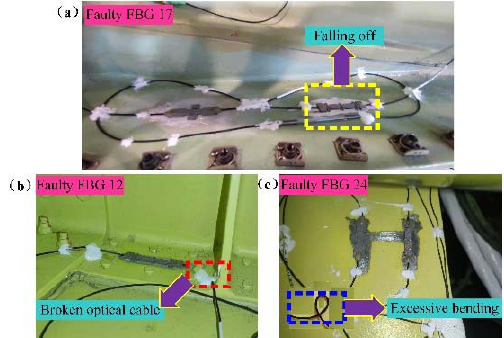
Figure 12. Diagram of faulty FBG sensors on airplane. ( a ) Falling off; ( b ) Broken optical cable; ( c )